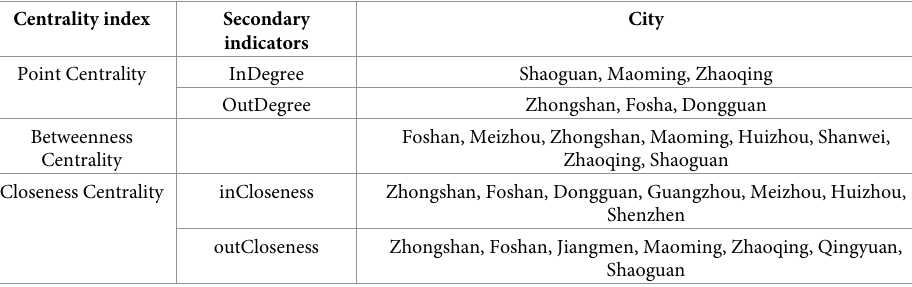
Table 10. Comparison of centrality analysis.